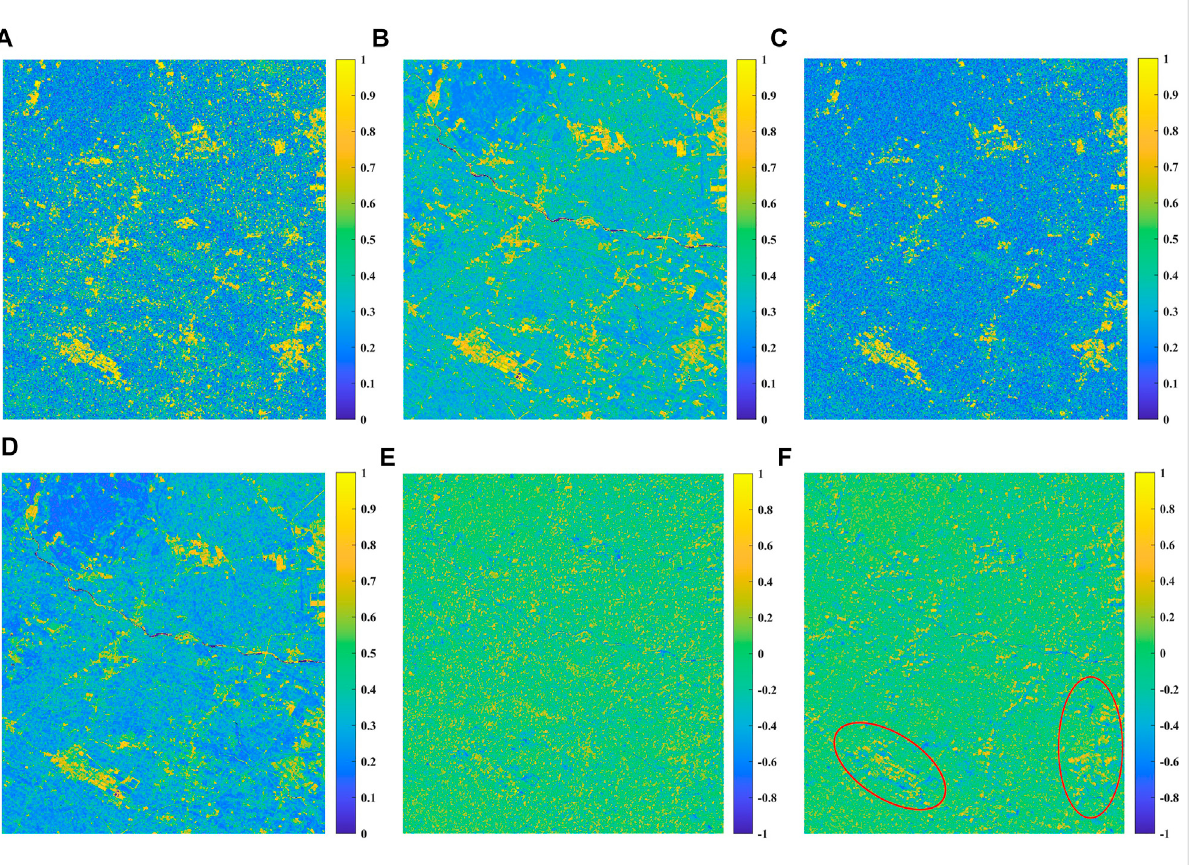
FIGURE 8 Coherenceimages ofthestudy area (A) TrueatVVchannel (B) Estimation atVVchannel (C) TrueatVHchannel (D) EstimationatVHchannel (E) Differences distribution at VV channel (F) Differences distribution at VH channel.